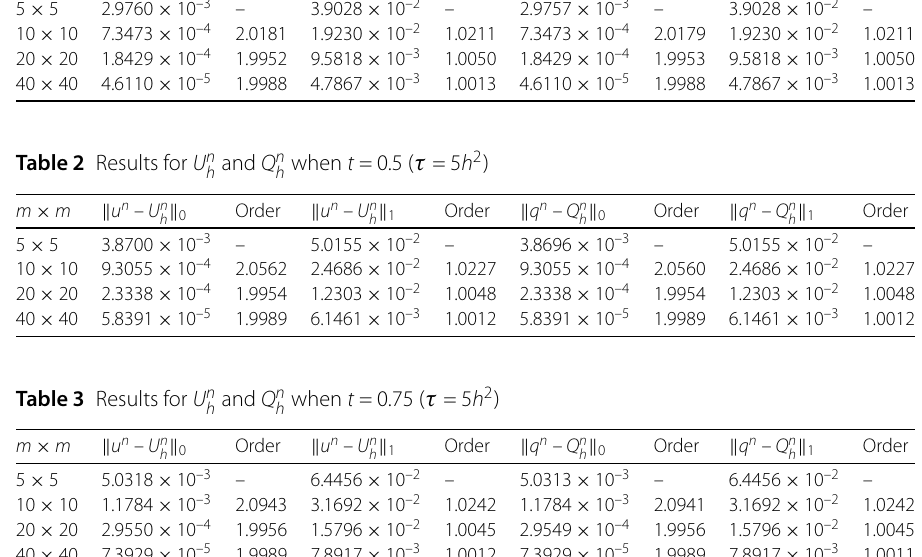
Table 1 Results for U n